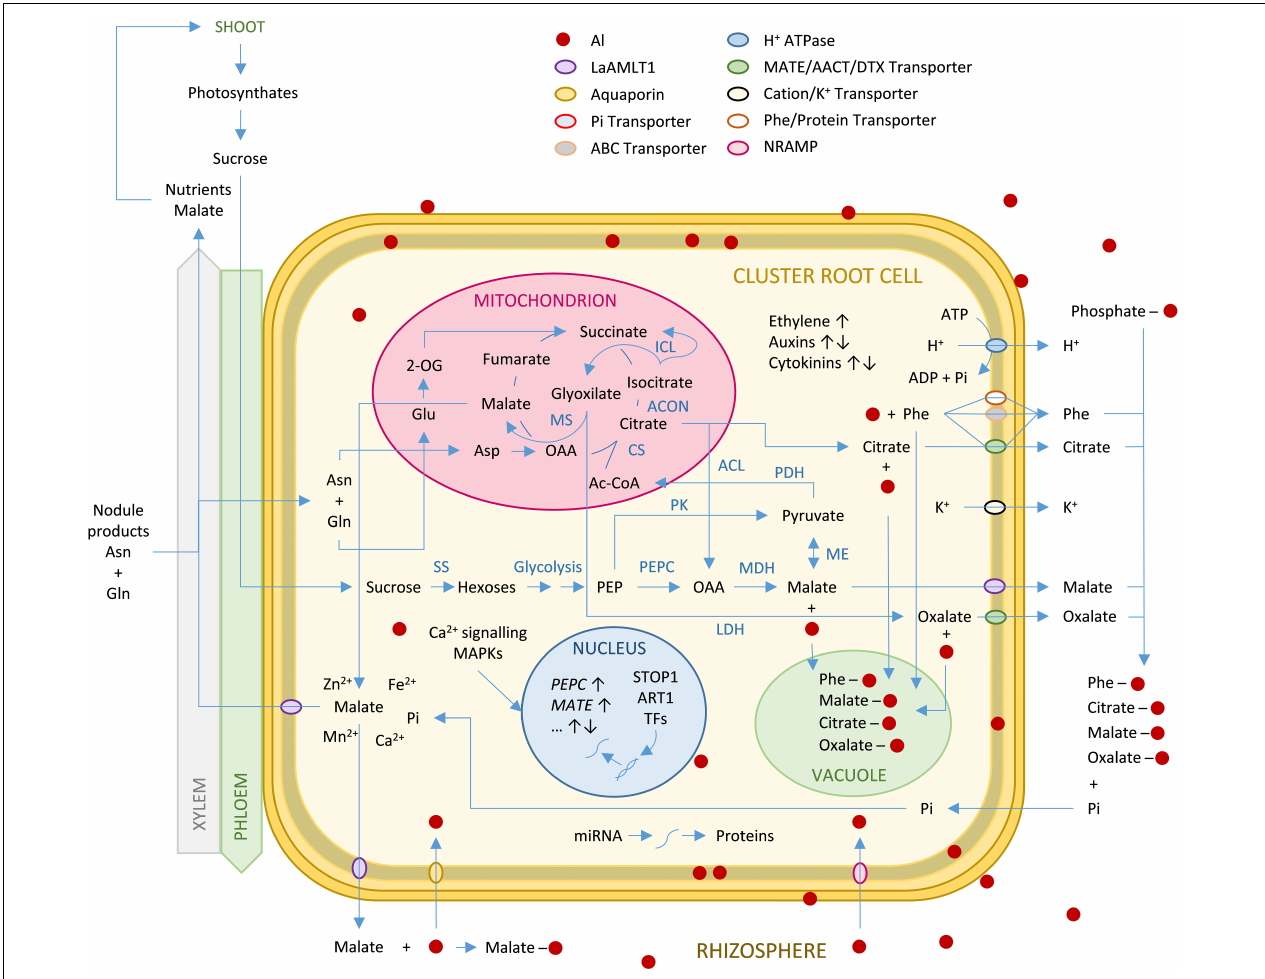
FIGURE 2 | Simplified metabolic pathways in a white lupin cluster root cell in response to Al stress. Aluminum present in the rhizosphere enters the cells primarily through aquaporins and NRAMP transporters. Through the action of Ca 2 + signaling pathways, transcription factors and miRNAs, Al induces replication of DNA that leads to activation of the TCA cycle, the glycolysis pathway and the glyoxylate cycle. This leads to the accumulation of organic acids and phenolic compounds. Activation of specific transport systems (MATE, ALMT, ABC-transporters) leads to the exudation of these compounds into the rhizosphere. OAs and phenolic compounds chelate Al cations outside and inside the cells. Intracellular complexes are accumulated in the vacuole. Extrusion of H + and K + contribute to the maintenance of the membrane potential. Ethylene production increases, while auxin and cytokinin levels increase or decrease depending on the developmental stage and the different root zones. Abbreviations: 2-OG, 2-oxoglutarate; AACT, aluminum-activated citrate transporter; ABC, ATP-binding cassette; ACON, aconitase; AMLT, aluminum-activated malate transporter; ACL, ATP citrate lyase; ART1, Al Resistance Transcription Factor 1; Ac-CoA, Acetyl CoA; Asn, asparagine; Asp, aspartic acid; CS, citrate synthase; DTX, detoxification transporter; Gln, glutamine; Glu, glutamic acid; ICL, isocitrate lyase; LDH, lactate dehydrogenase; MAPK, mitogen-activated phosphate kinase; MATE, multidrug and toxic compound extrusion; MDH, malate dehydrogenase; ME, malic enzyme; MS, malate synthase; NRAMP, natural resistance associated macrophage protein; OAA, oxaloacetate; PDH, pyruvate dehydrogenase; PEP, phosphoenolpyruvate; PEPC, PEP carboxylase; Phe, phenolic compounds; PK, PEP kinase; SS, sucrose synthase; STOP1, Transcription factor sensitive to protein rhizotoxicity 1; TFs, transcription